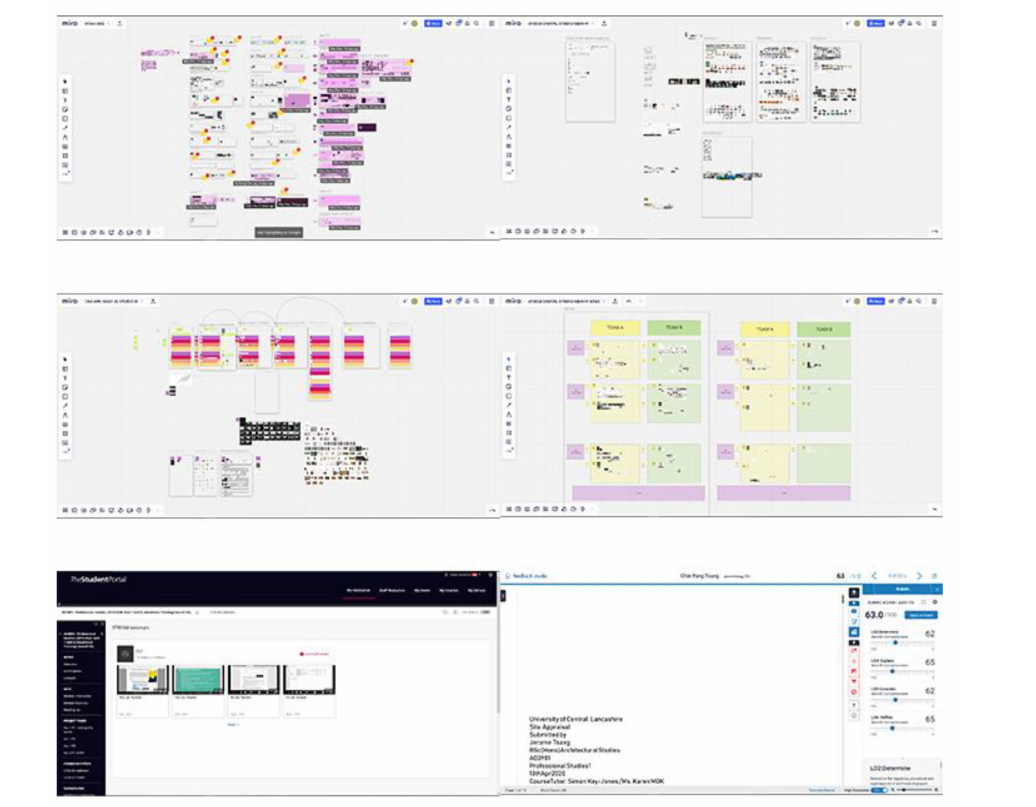
Figure 7. The online learning environment in action (Source: Simon Kay-Jones and Louise Janvier,